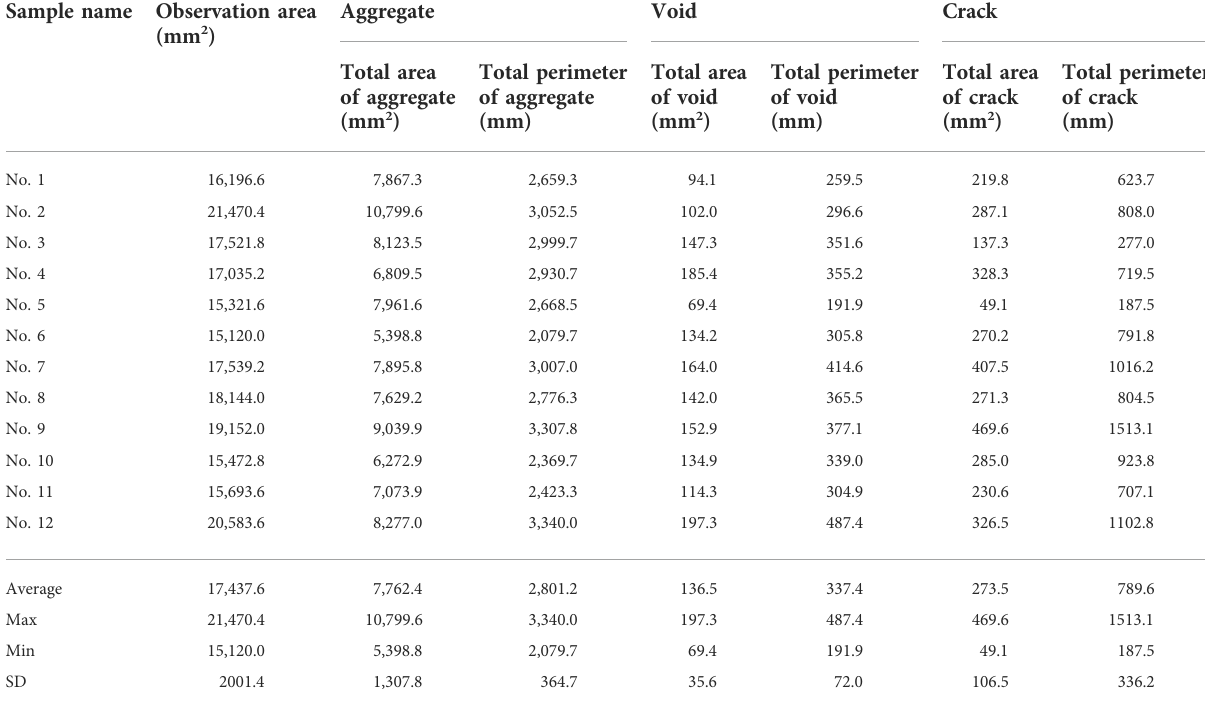
TABLE 4 Geometric properties of concrete